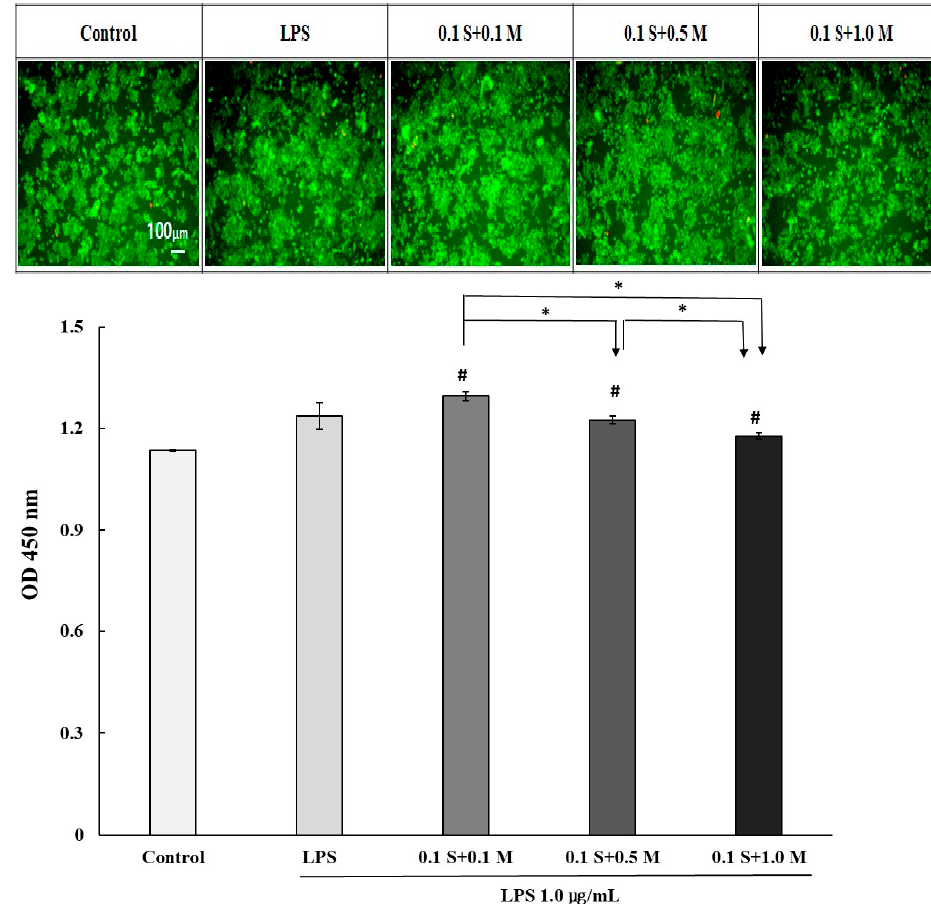
Figure 2. Cell viability based on the ratio of the sericin and MSM blends by CCK-8 assay using Raw 264.7 macrophage. Cell treated with 1.0 (0.1S + 0.1M), 5.0 (0.1S + 0.5M), and 10.0 (0.1S + 1.0M) mg/mL MSM at 1.0 mg/mL sericin, stimulated with 1 μ g/mL LPS. All values are presented as the mean ± standard deviation (n = 3). # p < 0.05 vs. CON. * p < 0.05.